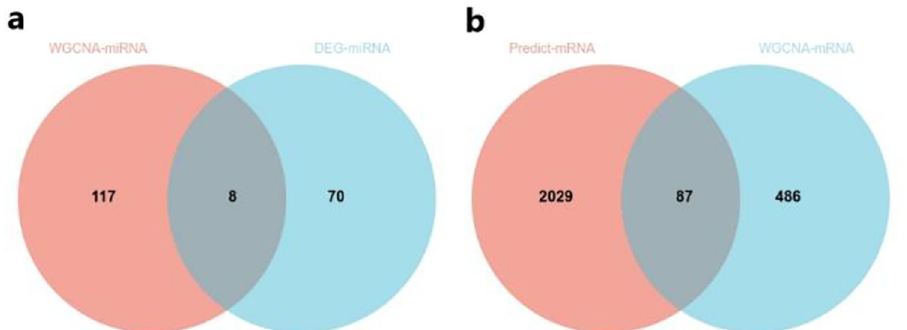
Fig 4. Wayne diagram of gene comparison result. (a) Wayne diagram was employed to intersect WGCNA-miRNAs and DEG-miRNAs and obtained 8 common miRNAs. (b) Wayne diagram was employed to intersect Predict-mRNAs and WGCNA-mRNAs and obtained 87 common mRNAs.